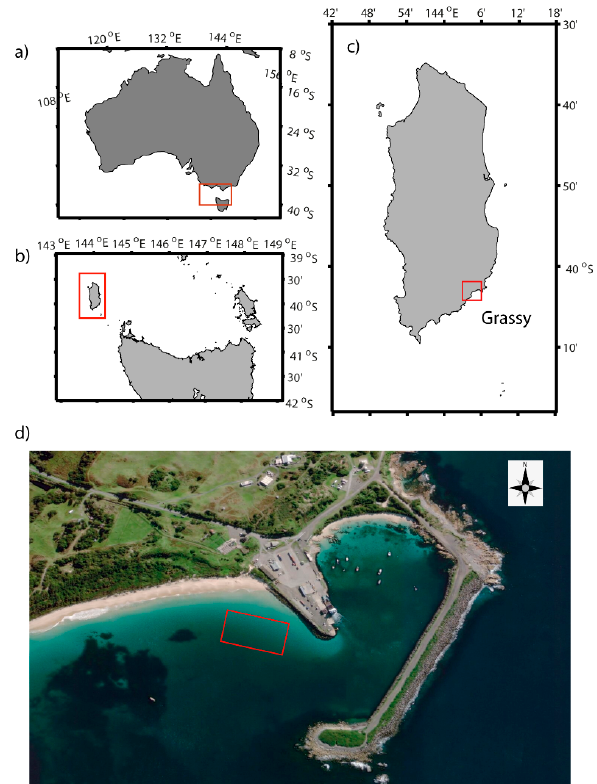
Figure 1. (a ) National map of Australia. ( b ) Regional scale of Northern Tasmania with the Furneaux Islands Group in the east and King Island in the west. ( c ) Local map of Tasmania with the location of Grassy on the southeast coastline. ( d ) Location and zoomed in satellite image of Grassy Harbour. The survey area is outlined by the red square near the rock wall of Grassy Harbour.